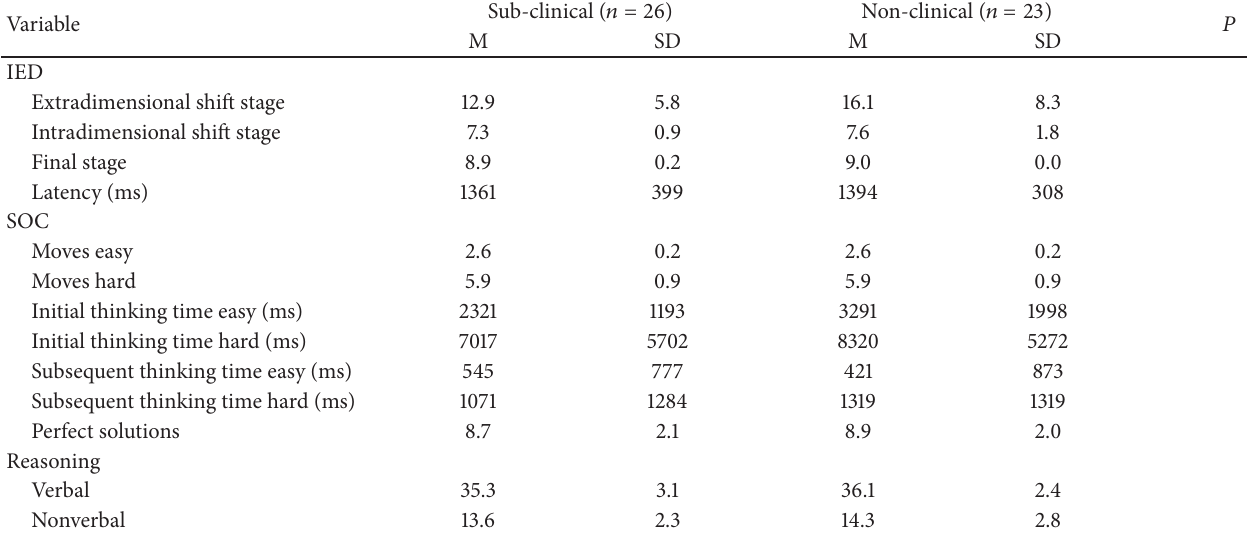
Table 5: Means and standard deviations in the sub-clinical and non-clinical groups for the IED, SOC, verbal, and nonverbal reasoning task measures.